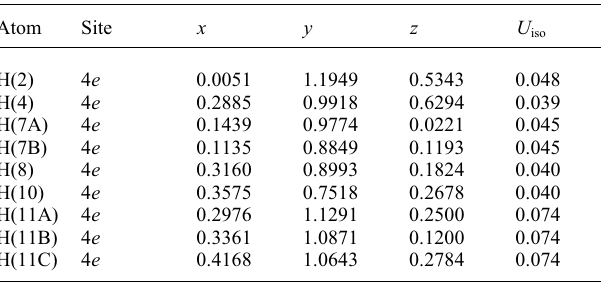
Table 2. Atomic coordinates and displacement parameters (in Å 2 )